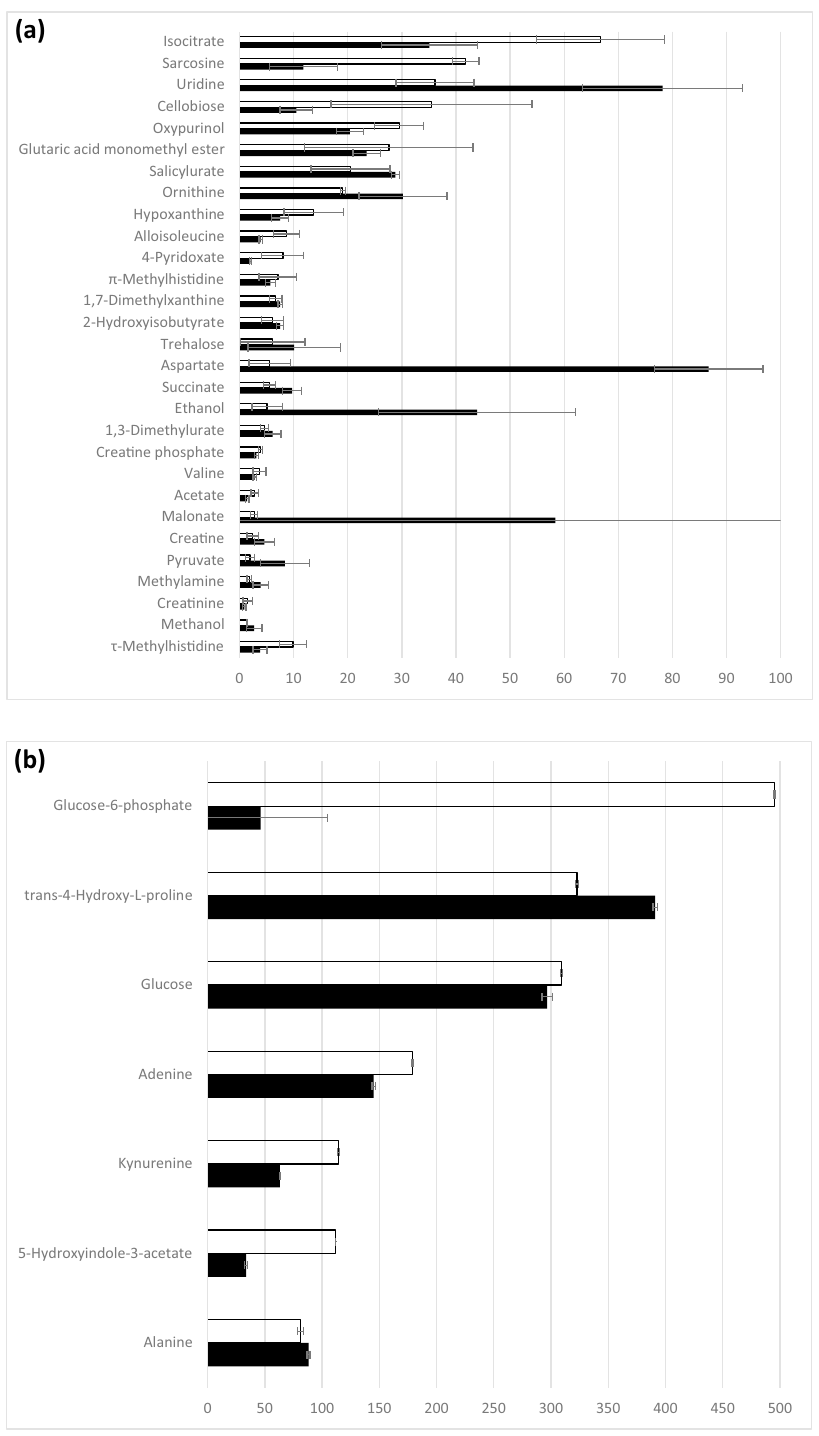
Figure 6. Black square planktonic and black filled square biofilm. ( a ) Low concentration range 0–100 mM ( b ) High concentration range 0–500 mM. Summary of the identified metabolites in Mycoplasma pneumoniae serum contributing an observed variation in component signal intensity of > 10% p = 0.05. Metabolites were assigned using Chemnomx Profiler. Certain duplicate signals (owing to multiplicity of single components in 1D 1 H NMR) have been removed and the signal intensities